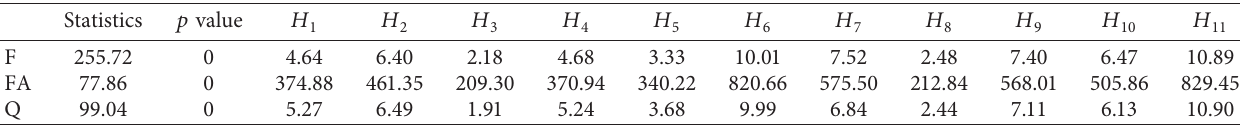
Table 7: Statistic test results for graph coloring instances for Friedman (F), Friedman Aligned (FA), and Quade (Q). Statistics